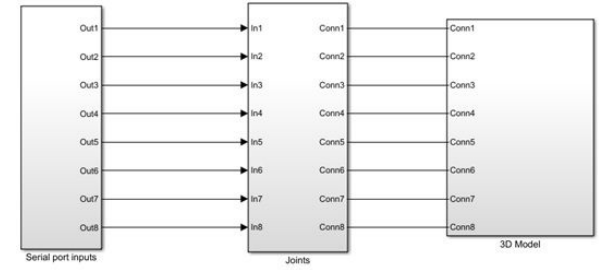
Figure 9: Matlab Simulink blocks.